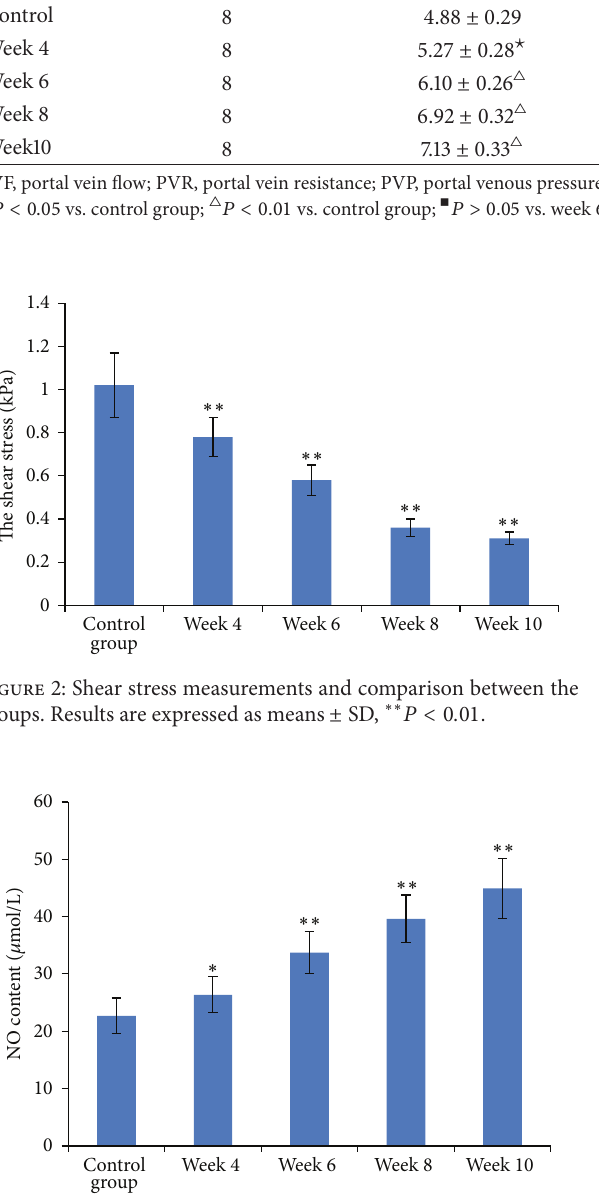
Figure 5: ET-1 content in portal venous blood among the groups. Results are expressed as means ± SD, ∗∗ 𝑃 < 0.01 versus the control